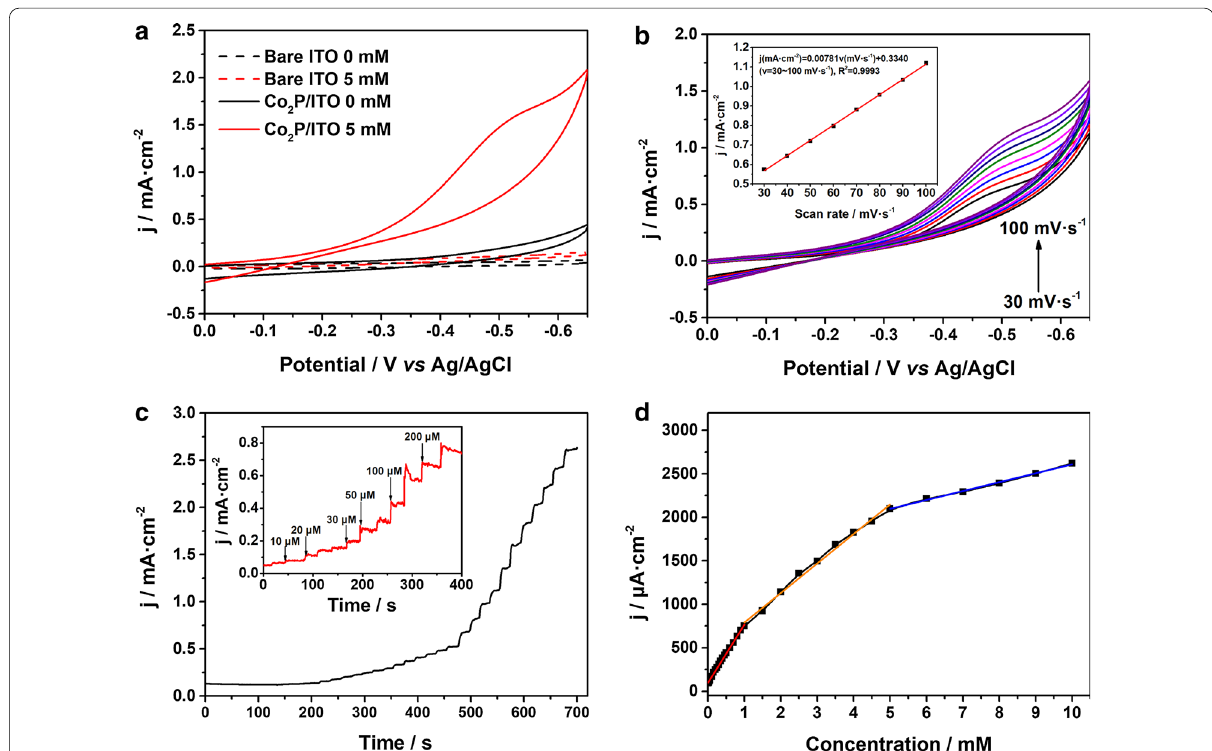
Fig. 2 a CV curves of bare ITO and Co 2 P/ITO electrode in 0.1 M PBS with and without 5.0 mM H 2 O 2 at a scan rate of 100 mV s − 1 . b CV curves of Co 2 P/ITO electrode in 2.5 mM H 2 O 2 at scan rates from 30 to 100 mV s − 1 . Inset: The corresponding plot of current versus the scan rate. c Amperometric responses of Co 2 P/ITO electrode with successive addition of H 2 O 2 in 0.1 M PBS. d The calibration curve of steady current versus the concentration of H 2 O